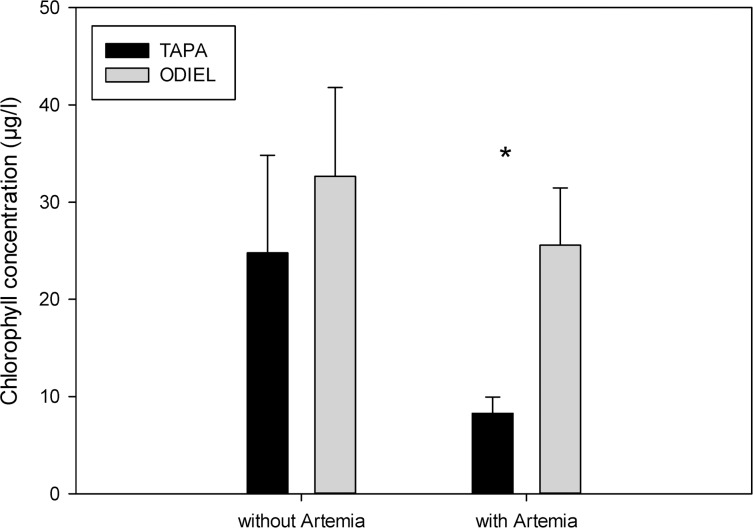
Chlorophyll-a concentration in presence and absence of Artemia.Comparison of chlorophyll-a concentration between la Tapa (occupied by A. franciscana) and Odiel (A. parthenogenetica) in ponds with and without Artemia from April to December 2011. Sample sizes: Tapa without Artemia = 11, Odiel without = 13, Tapa with Artemia = 16, Odiel with = 14. * indicates a significant difference (p = 0.006) between locations for ponds with Artemia.